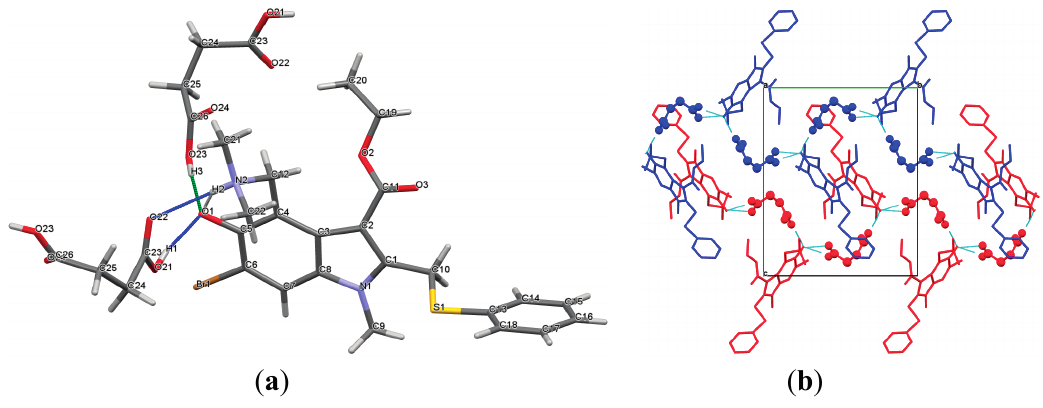
Figure 4. ( a ) Hydrogen-bonded molecular unit in the [ Arb + Suc ] crystal; ( b ) molecular packing arrangement of the [ Arb + Suc ] crystal. The neighboring ribbons of the H-bonded Arb and Suc molecules are colored in red and blue. H atoms are